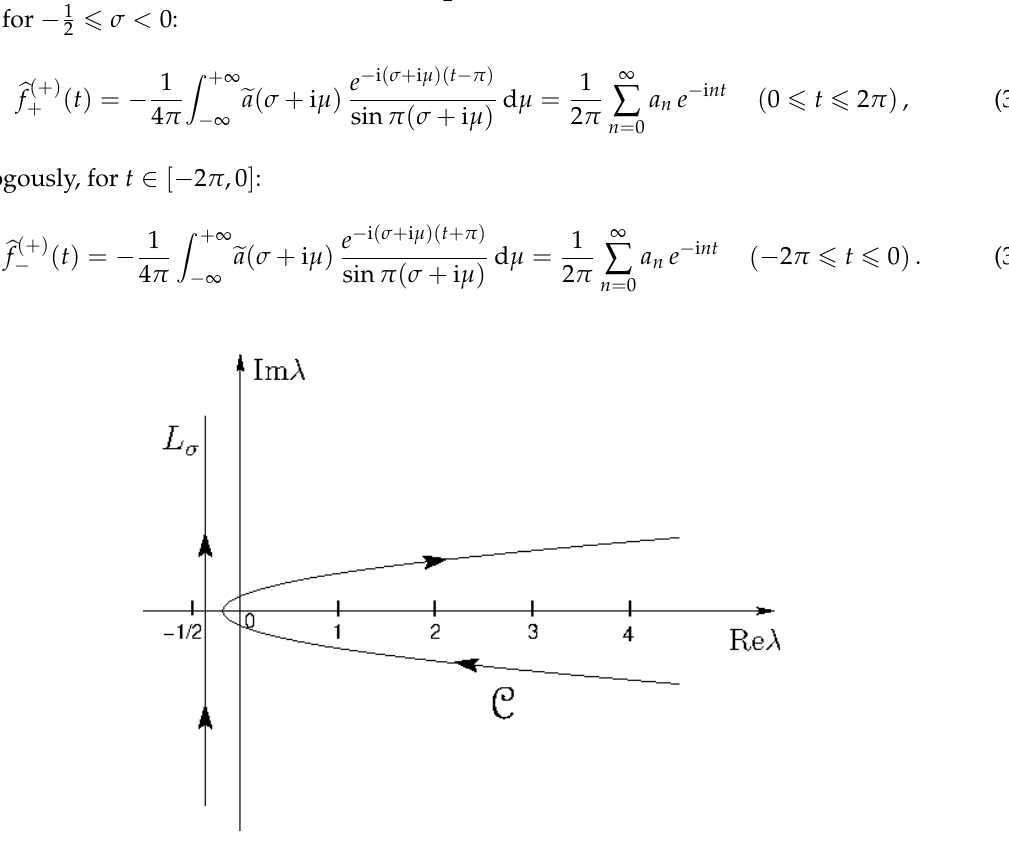
Figure 3. Integration path of integral